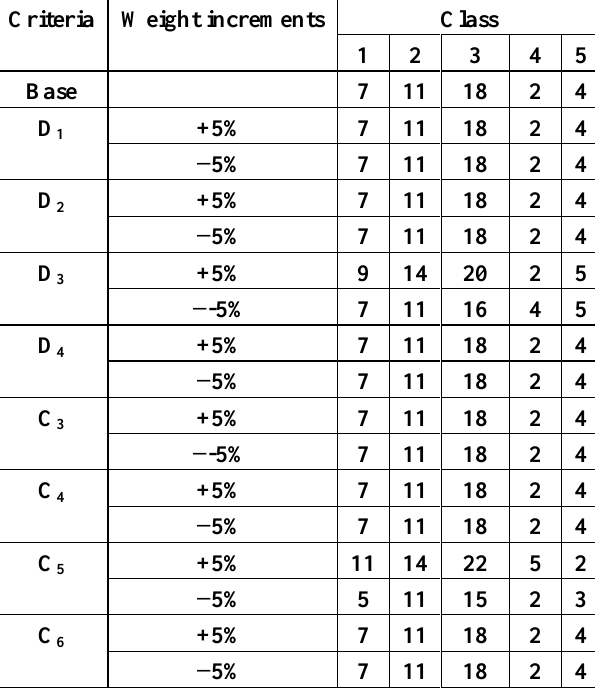
Table 16. Results of sensitivity